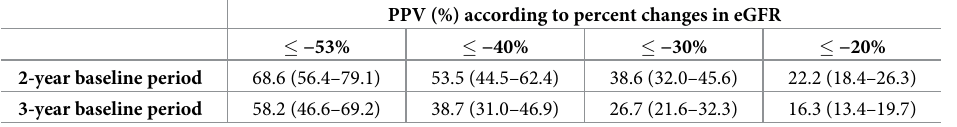
Table 3. Positive predictive value (PPV) with 95% confidence interval for end-stage renal disease according to percent changes in eGFR during the 2-year and 3-year baseline periods. PPV (%) according to percent changes in eGFR (cid:20) −53% (cid:20) −40% (cid:20) −30% (cid:20)